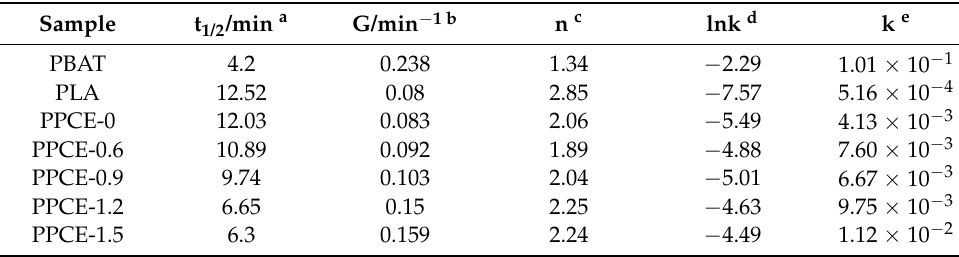
Table 2. Semi-crystallization time, crystallization rate, and Avrami-model parameters for different samples at atmospheric pressure and a temperature of 90 ◦